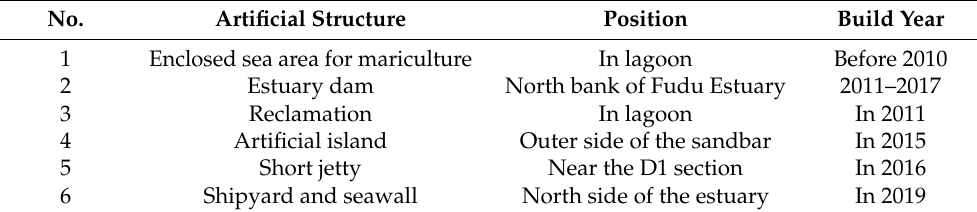
Table 2. Coastal construction activities around the FESL.